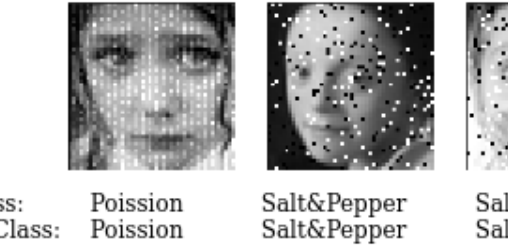
Figure 12. Test Image actual and predicted